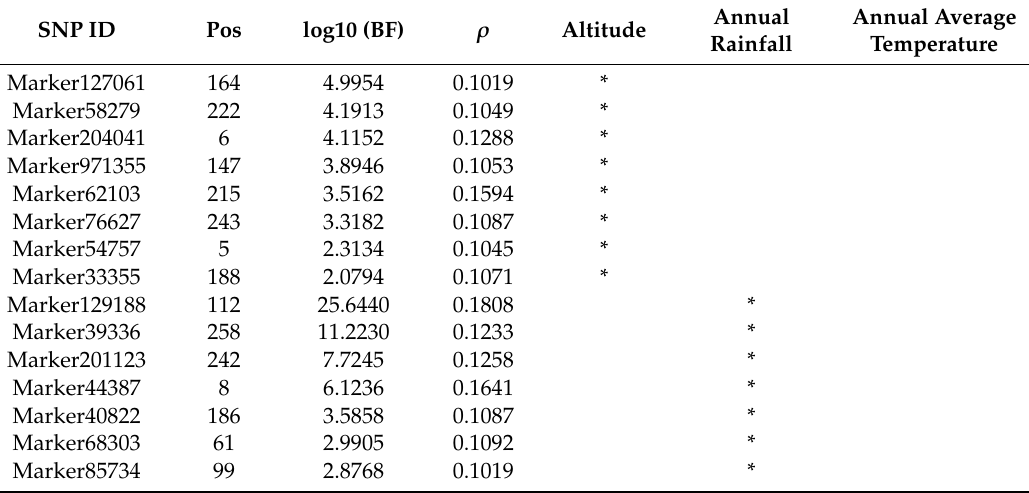
Table 6. A summary of putative adaptive markers displaying associations with different climate variables identified by Bayenv2 analysis.